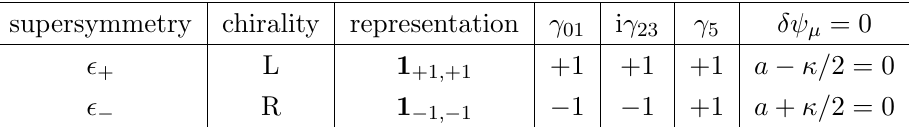
Table 2 . Supersymmetry generators and their charges under Spin(1 ; 1), Spin(2) (cid:6) and